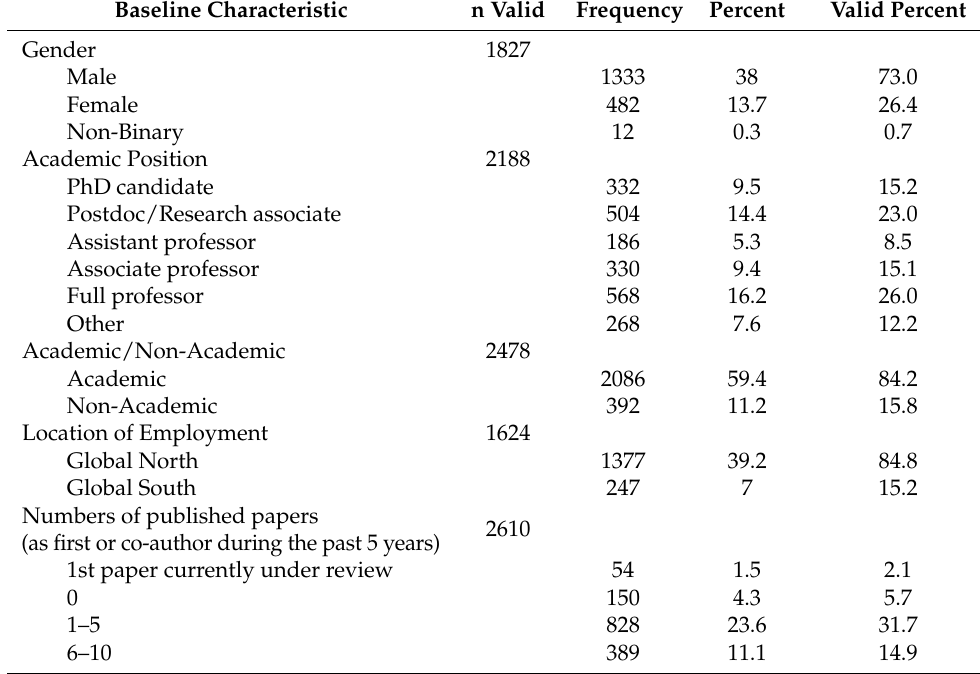
Table 1. Descriptive statistics of the control variables of N = 3509 survey respondents. “Percent” is based on the total N (3509), while “Valid Percent” is based on “n valid”, which excludes missing data. Baseline Characteristic n